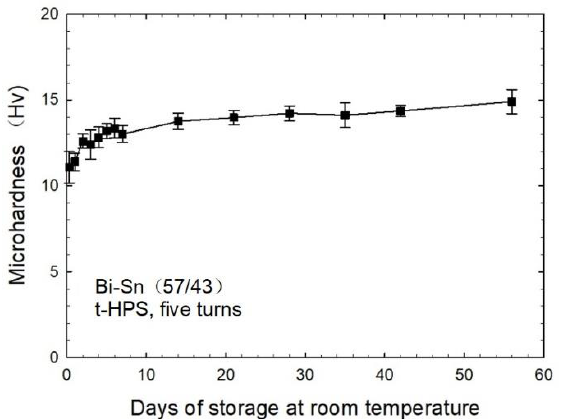
Figure 4. Microhardness of the Bi–Sn samples versus the number of days of storage at RT after t-HPS processing for five turns.